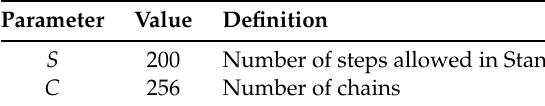
Table 4. Parameters for TI-Stan examples.